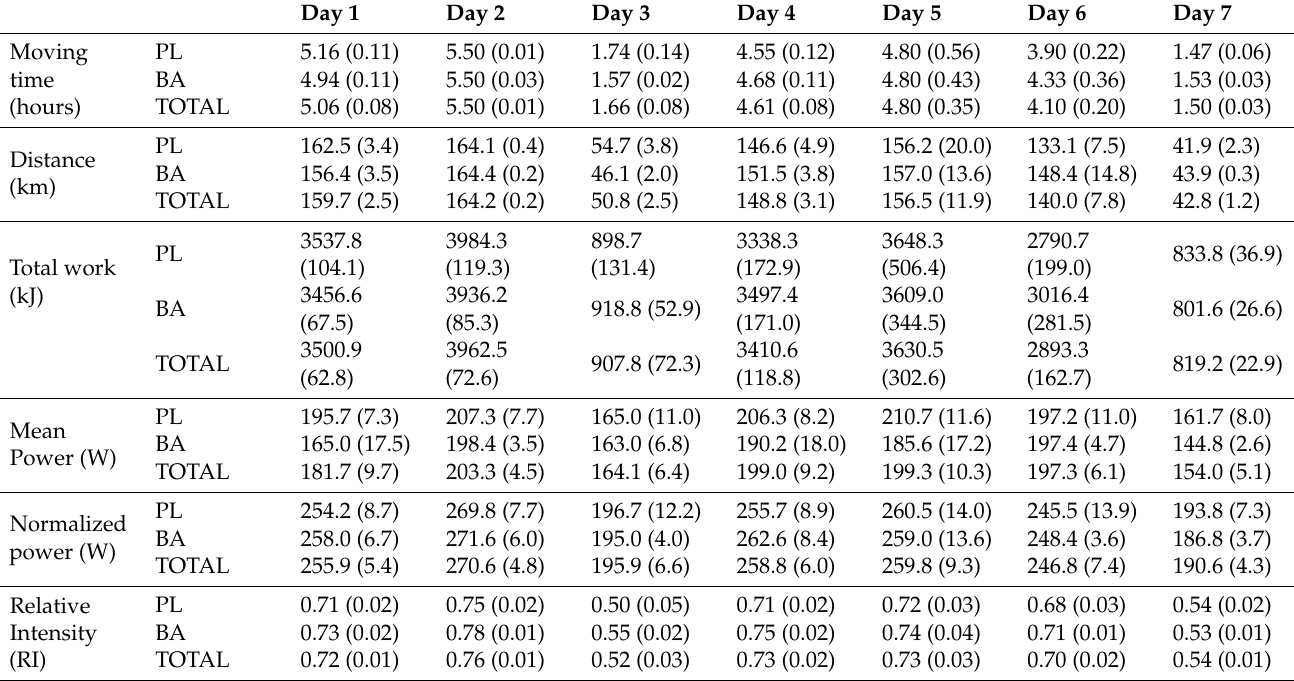
Table 5. Description of training schedule per day. Values are presented as mean with standard error of the mean (between